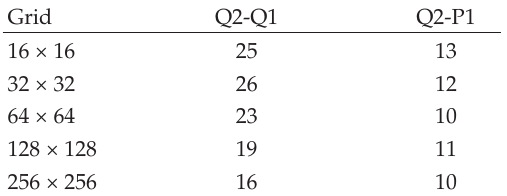
Table 4: Iterations of preconditioned GMRES (cid:4) 30 (cid:5) for generalized Stokes problems.